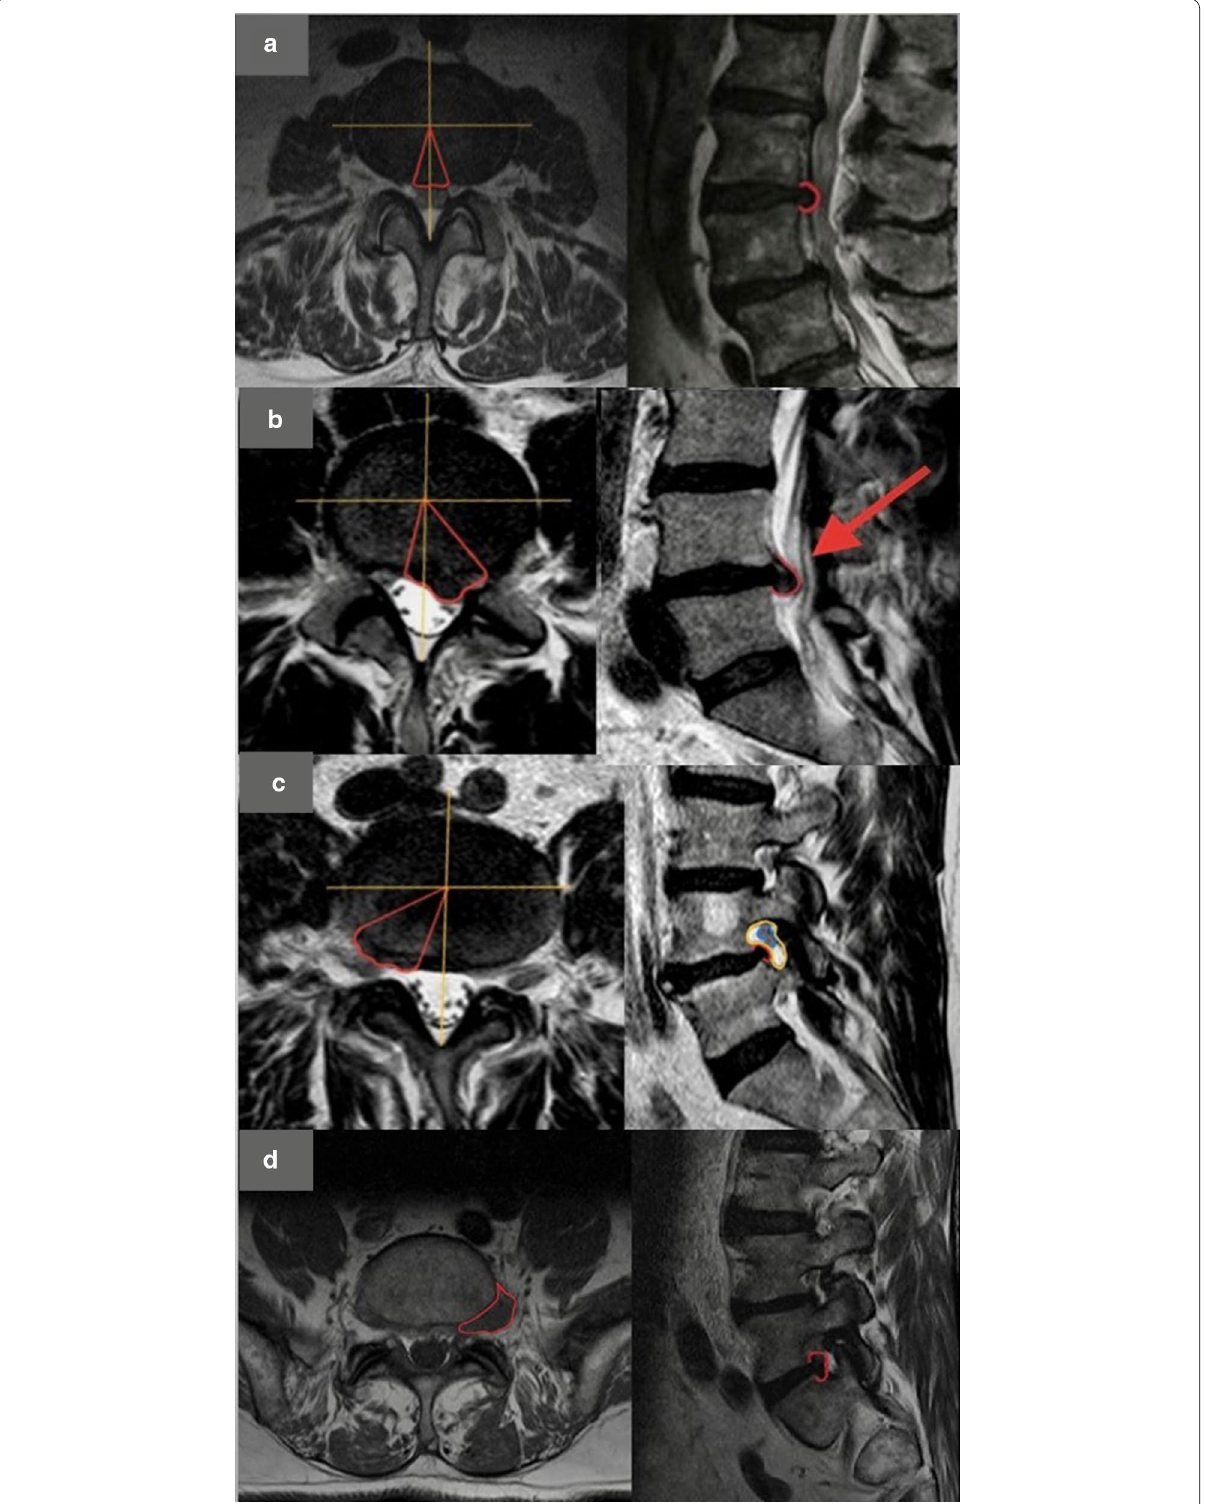
Fig. 3 a Example of central localization of herniated disc (bordered in red). b Example of lateral localization of herniated disc (bordered in red). c Example of foraminal localization of the discal protrusion (bordered in red). In sagittal plane, the foraminal space is bordered in yellow and the corresponding nerve root in blue. d Example of extraforaminal localization of the herniated disc (bordered in